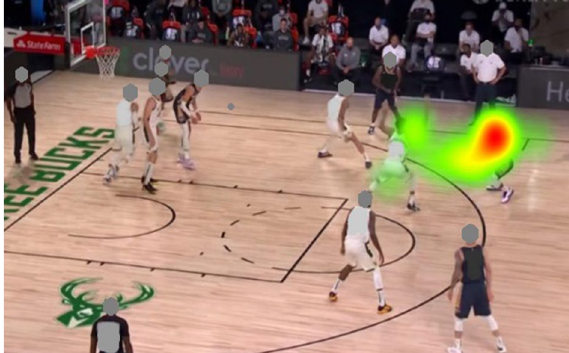
Figure 10. Heat map for